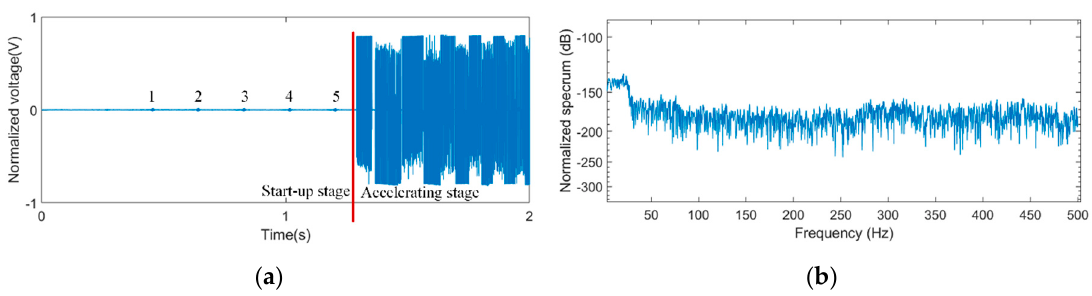
Figure 5. Common mode voltage of linear generation output in the ( a ) time domain and ( b ) frequency domain.